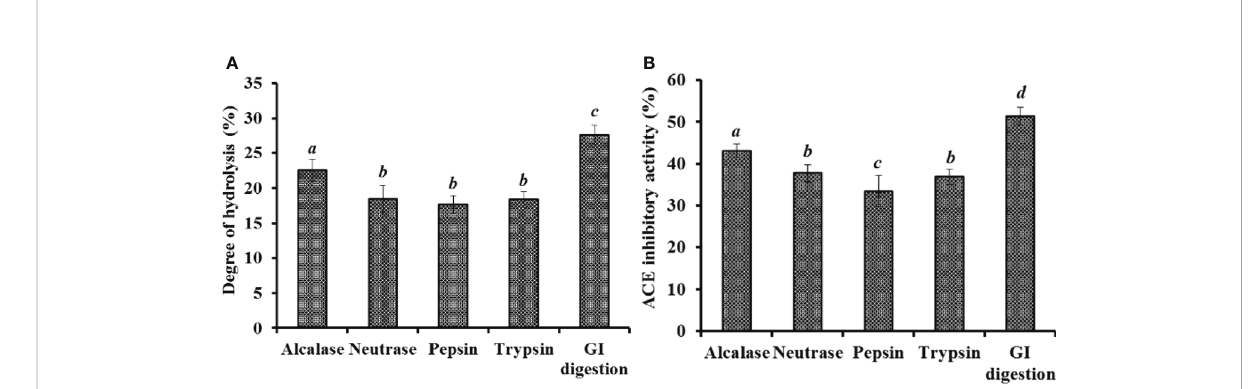
FIGURE 1 Degree of hydrolysis (%) (A) and ACEi activity (%) (B) of swim bladder hydrolysates of miiuy croaker using four proteases and in vitro GI digestion method. All values are means ± SD (n = 3). a – d Same letters indicate no signi fi cant difference ( p <